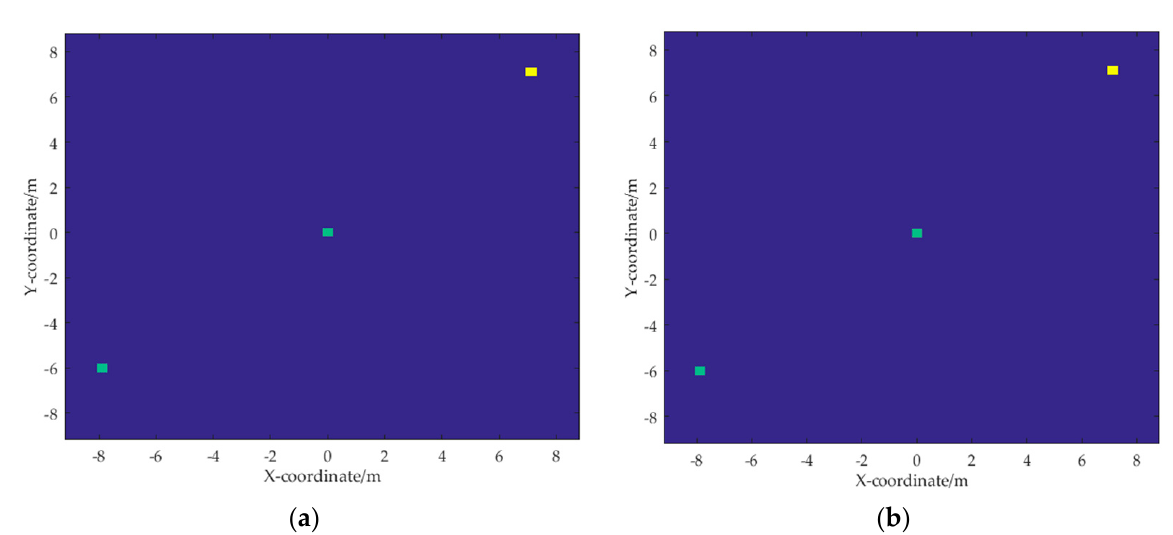
Figure 15. Azimuth image on a single range unit. ( a ) The 22nd range unit’s azimuth image of basis pursuit algorithm; ( b ) The 22nd range unit’s azimuth image of OMP algorithm.